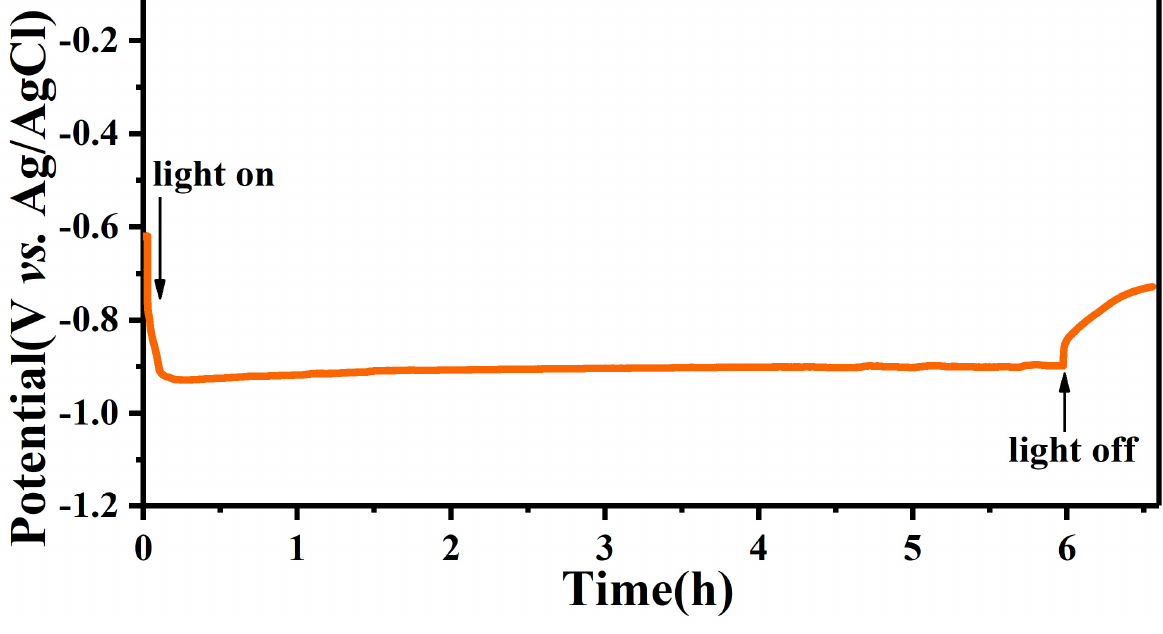
Figure 7. Long ‐ term OCP variation in 304 SS coupled with the ZnO/Bi 2 S 3 photoanode under contin ‐ Figure 7. Long-term OCP variation in 304 SS coupled with the ZnO/Bi 2 S 3 photoanode under uous illumination for 6 h. continuous illumination for 6